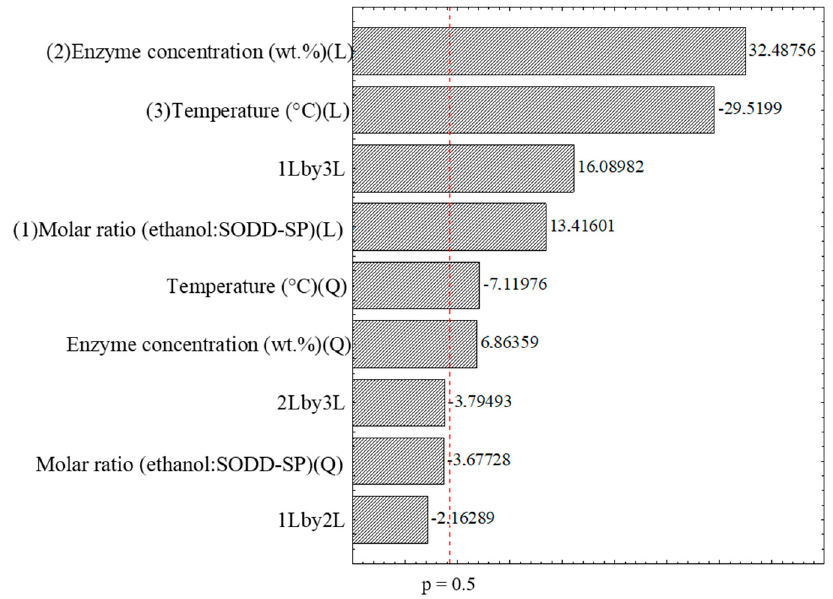
Figure A2. Pareto chart with the effects of the parameters and their interactions for the experimental design of the esterification/transesterification with SODD saponifiable phase and ethanol using Eversa Transform 2.0 as biocatalyst.